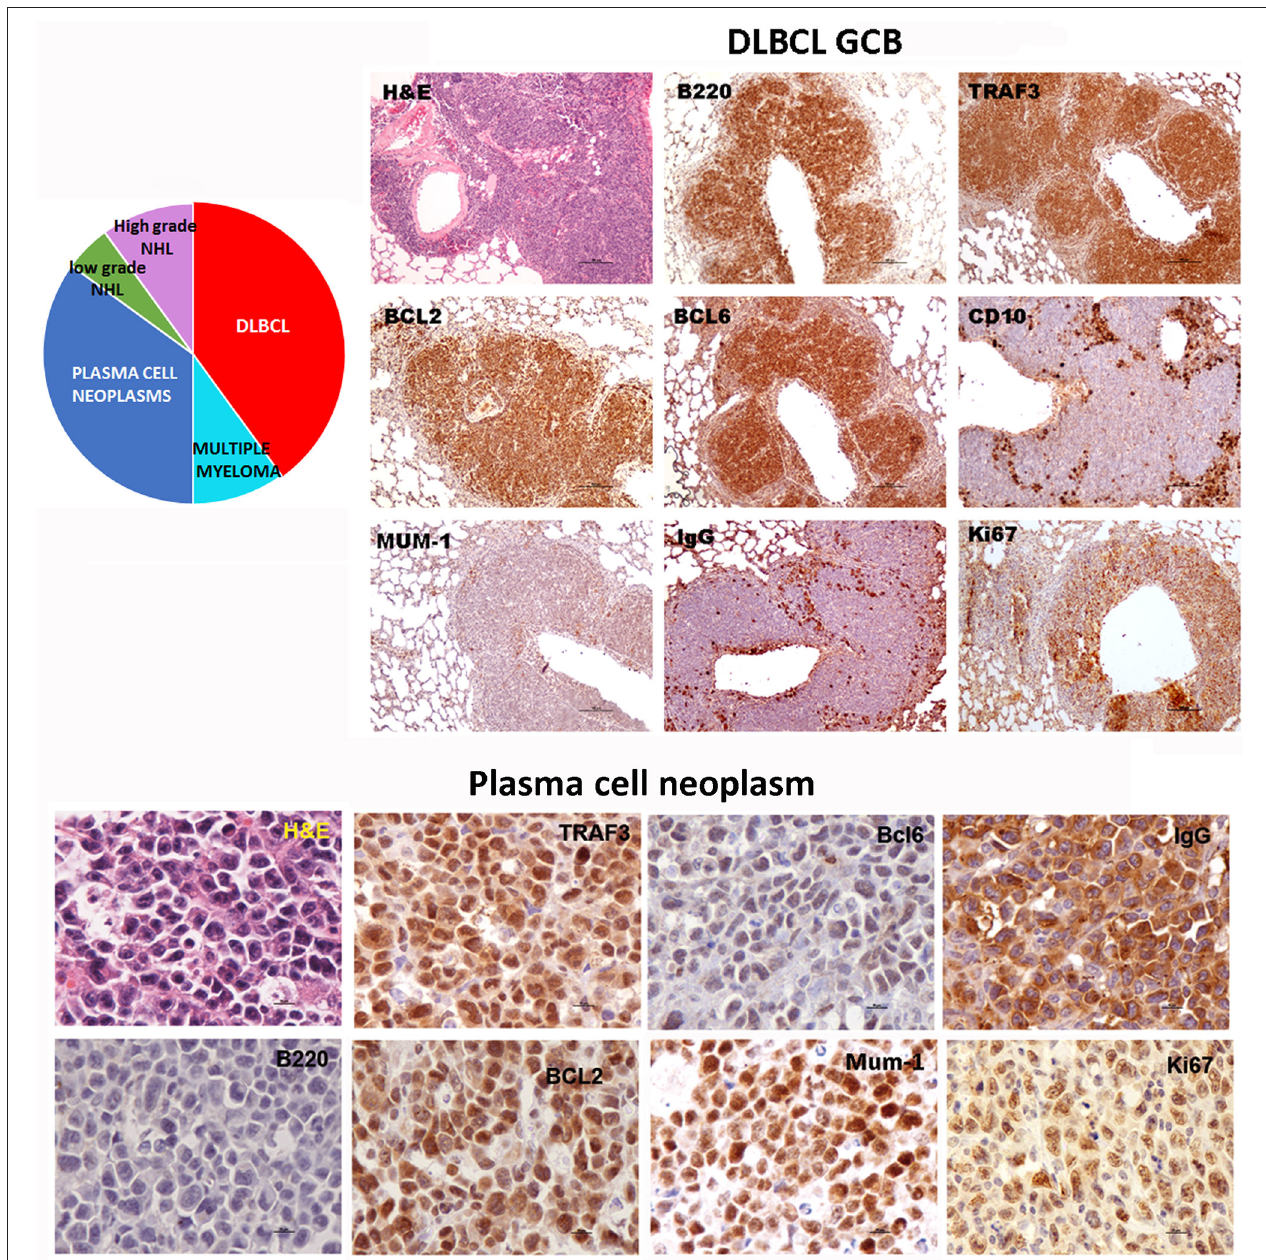
FIGURE 3 | TRAF3/BCL2 double-tg mice develop different types of mature B cell neoplasias, but predominantly DLBCL and plasma cell neoplasias. Immunohistochemical analysis of representative examples of a DLBCL GCB type and a plasma cell neoplasia developed by the TRAF3/BCL2 double-tg mice. Tissue slides were stained either with H&E or with antibodies specific for human TRAF3 and BCL2 and for mouse CD45B220, BCL6, MUM-1, CD10, IgG and Ki67, as indicated. Scale bars are 100 µ m (DLBCL) and 10 µ m (plasma cell neoplasia). A diagram indicating the frequency of the different lymphoid neoplasias found in the TRAF3/BCL2 double-tg mice is shown ( n =